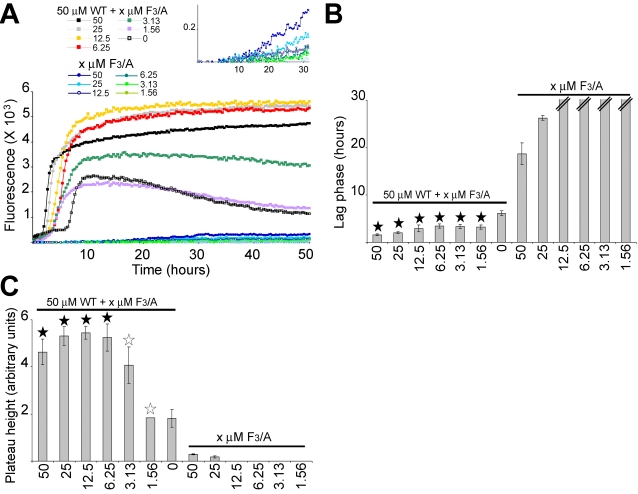
Effect of the mutant peptide F3/A on AChE586-599 fibrilization.Varying concentrations of the mutant F3/A were incubated with 165 µM ThT, with or without 50 µM AChE586-599. Changes in ThT fluorescence were monitored (A) with the lag phase of fibrilization (B) and the plateau height (C) depicted. The mutant peptide F3/A decreases the lag phase of AChE586-599 (A, with the inset showing a scale-up to visualize the fibrilization of the F3/A mutant on its own; and B), and increases the plateau height of AChE586-599 (A and C). A black star signifies p<0.03 (B) and p<0.05 (C) when compared to both 50 µM AChE586-599 and the equivalent concentration of the F3/A mutant. A white star signifies p<0.05 (C) when compared to the equivalent concentration of the F3/A mutant. The double bar in B indicates the absence of fibrilization (i.e. an indeterminably long lag phase).